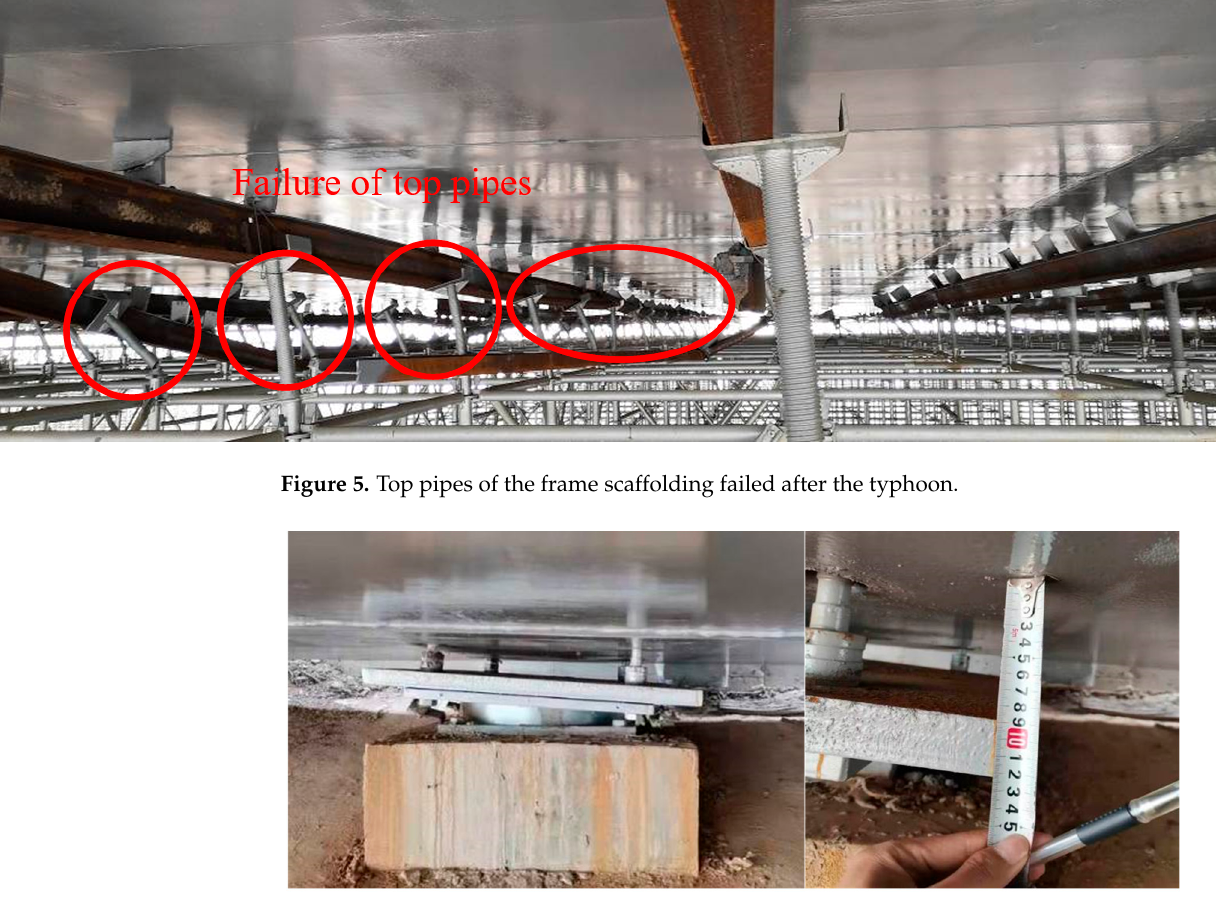
Figure 6. Bearings of the bridge separated the box girder and the pad stones.